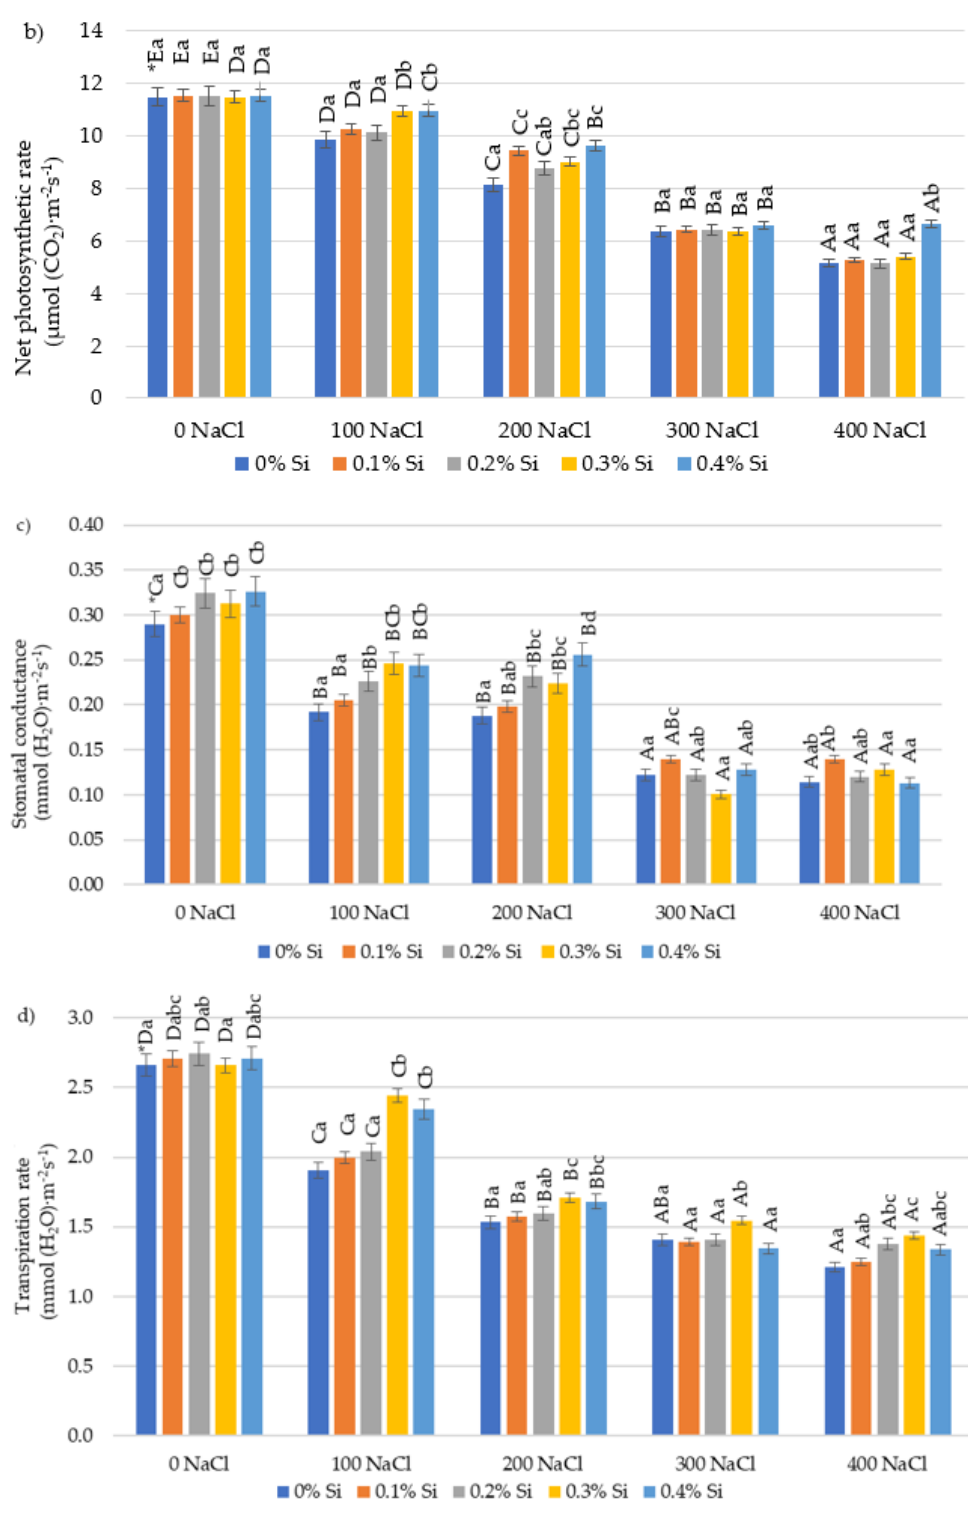
Figure 3. The effect of Si on gas exchange parameters: ( a ), intercellular CO 2 concentration ( b ), transpiration rate ( c ) stomatal conductance ( d ) net photosynthetic rate in maize leaves cultivated in varying salinity conditions. * Capital letters indicate significant differences between the mean values for soil salinity at the same doses of Si. The lowercase letters represent the mean significant differences among the doses of Si at the same salinity ( p = 0.05).